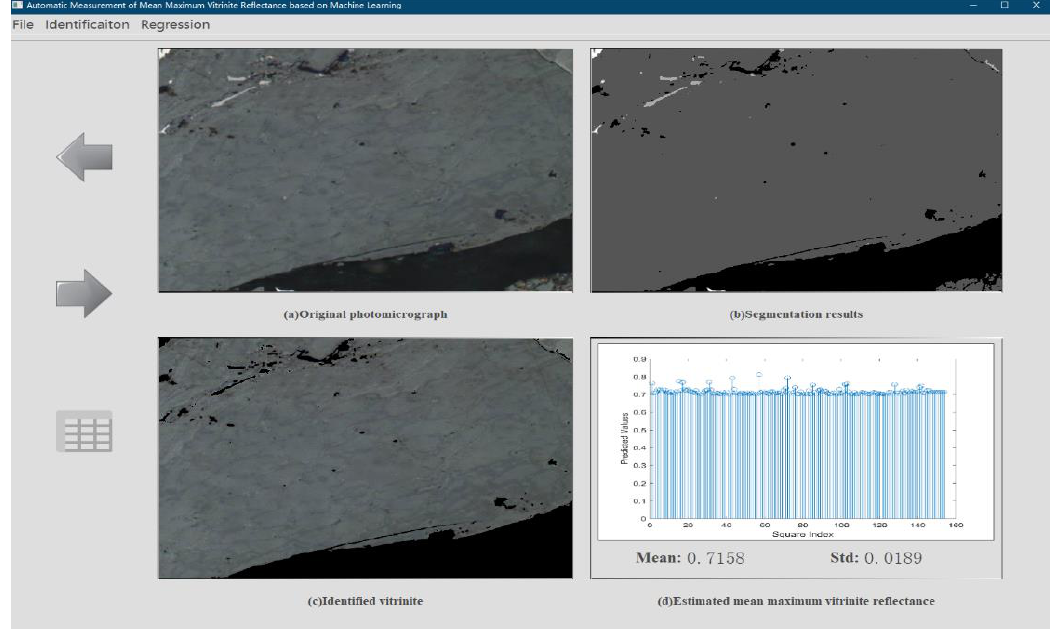
Figure 9. The user interface of MMVRML for automatic MMVR measurement.